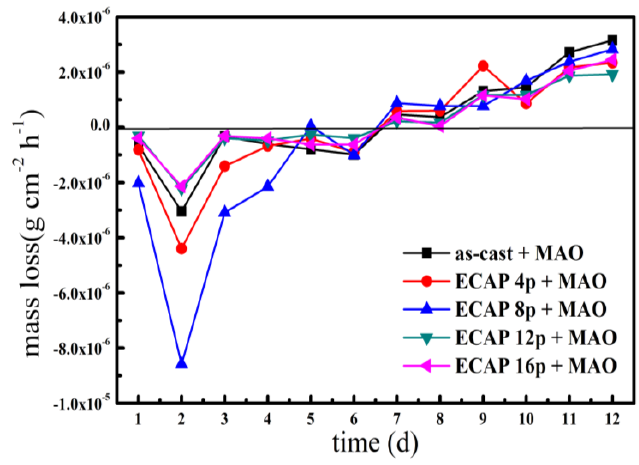
Figure 5. Relationship between the mass loss and the immersion time of the MAO samples in 3.5 wt % NaCl solution.